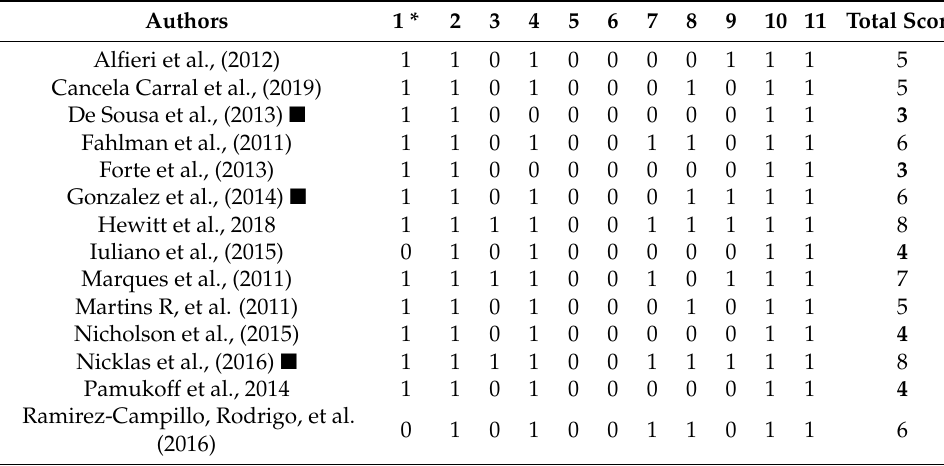
Table 1. PEDro—Quality